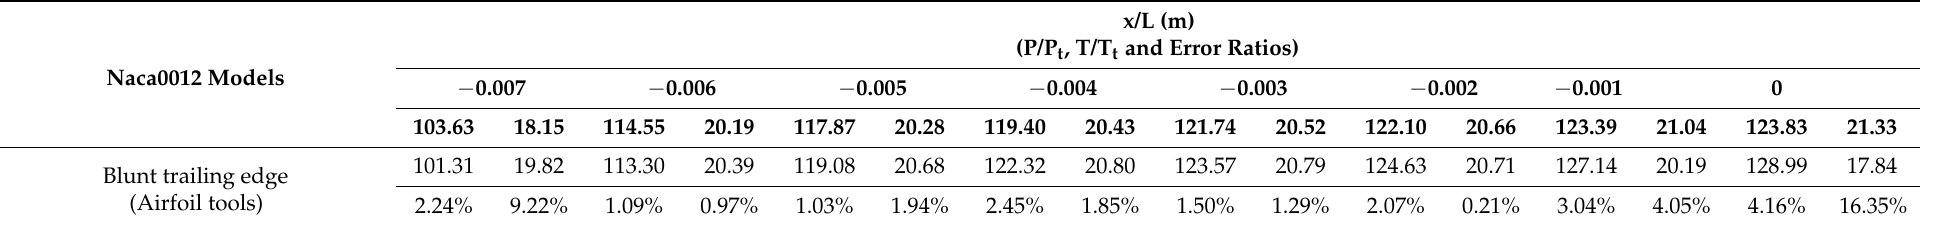
Table 10. Numerical results of P/P t , T/T t and Error Ratios adopting SST k-omega and far-field distance of 16